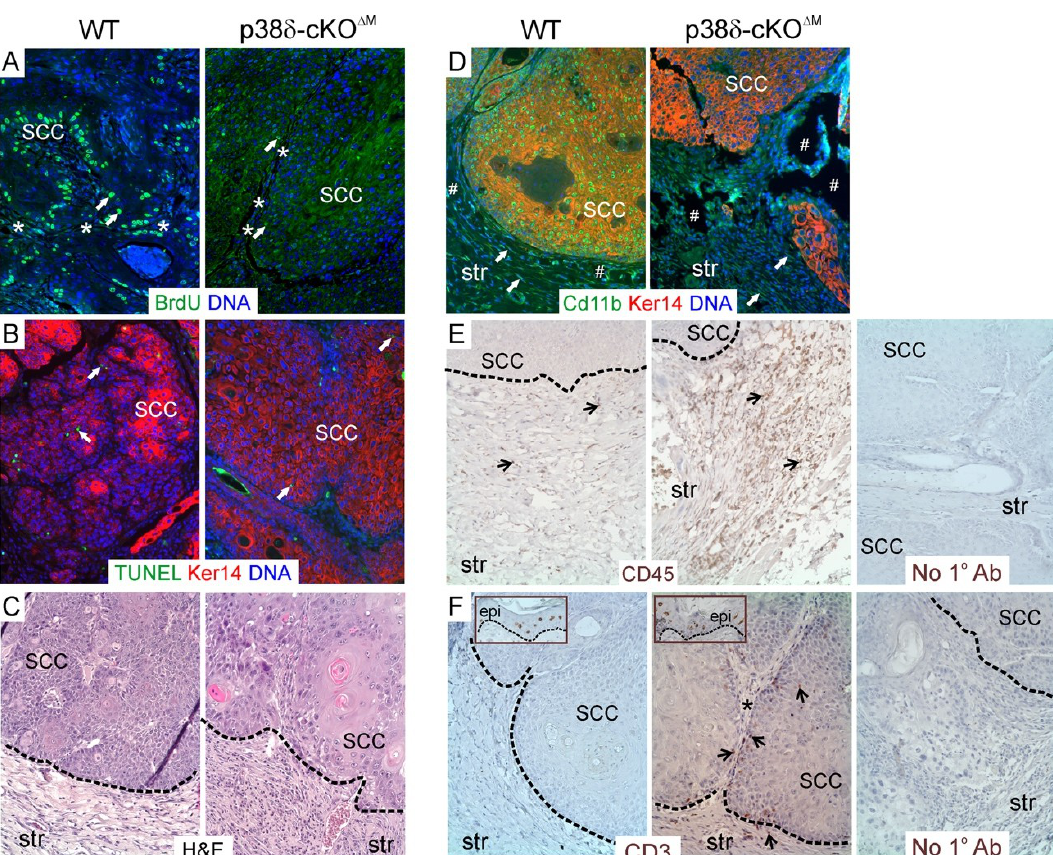
Figure 4. SCC tumors from myeloid p38 δ -deficient male mice exhibit reduced tumor cell proliferation, similar levels of apoptosis, and increased leukocyte recruitment into the peritumoral stroma compared with SCC tumors from WT male mice. Representative sections of WT and p38 δ -cKO ∆ M SCC tumors, collected after the completion of the carcinogenesis experiment, are shown; n = 3 tumor samples per genotype were examined. ( A ) Immunofluorescence staining for BrdU (green) showing markedly reduced numbers of BrdU + nuclei in p38 δ -cKO ∆ M SCC tumors compared with WT SCC tumors. White arrows point to representative BrdU-positive nuclei. Asterisks mark regions of intratumoral stroma. ( B ) Immunofluorescence staining for TUNEL and Keratin 14 (Ker14). White arrows point to representative TUNEL + apoptotic nuclei (green). Ker14 positivity (red) marks epithelial compartment of SCCs. ( C ) H&E staining shows a higher density of inflammatory cells in the peritumoral stroma of p38 δ -cKO ∆ M SCC tumors compared with WT tumors. ( D ) Immunofluorescence staining for CD11b (green) and Ker14 (red). White arrows point to representative CD11b + myeloid cells in the peritumoral stroma of SCCs. Note the higher density of CD11b + cells in the stroma of p38 δ -cKO ∆ M SCC tumors. # marks regions of poor tissue preservation. ( E ) Immunohistochemical staining for CD45 pan-leukocyte marker shows increased leukocyte infiltration into the peritumoral stroma of p38 δ -cKO ∆ M SCC tumors compared with WT SCC tumors. Black arrows point to representative CD45 + cells. ( F ) Immunohistochemical staining for CD3 (T cells, brown). Black arrows point to representative CD3 + cells. CD3 + cells are seen in the parenchyma as well as in the intratumoral (asterisk) and peritumoral stroma of p38 δ -cKO ∆ M SCC tumors, but not in WT SCC tumors. Insets show CD3 + dendritic epidermal T cells in epidermis of WT and p38 δ -cKO ∆ M skin adjacent to the corresponding SCC tumors, providing an intrinsic positive control for CD3 staining. In ( A , B , D ), nuclei were counterstained with Hoechst dye (DNA). In ( C , E , F ), dashed line demarcates tumor-stromal boundaries. In ( E , D ), no primary antibody panels (No 1 o Ab) are included as negative controls. SCC, squamous cell carcinoma; str, stroma; epi, epidermis; Magnification, 20 ×.